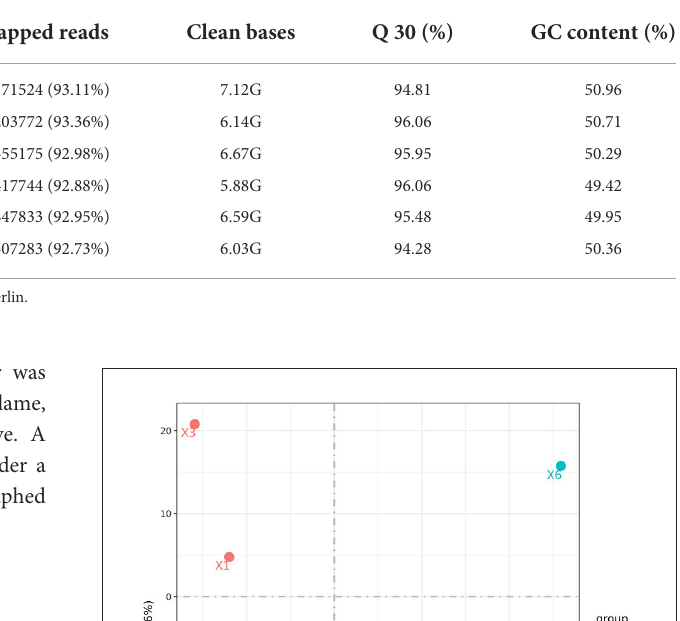
TABLE 1 RNA sequencing data and quality control.